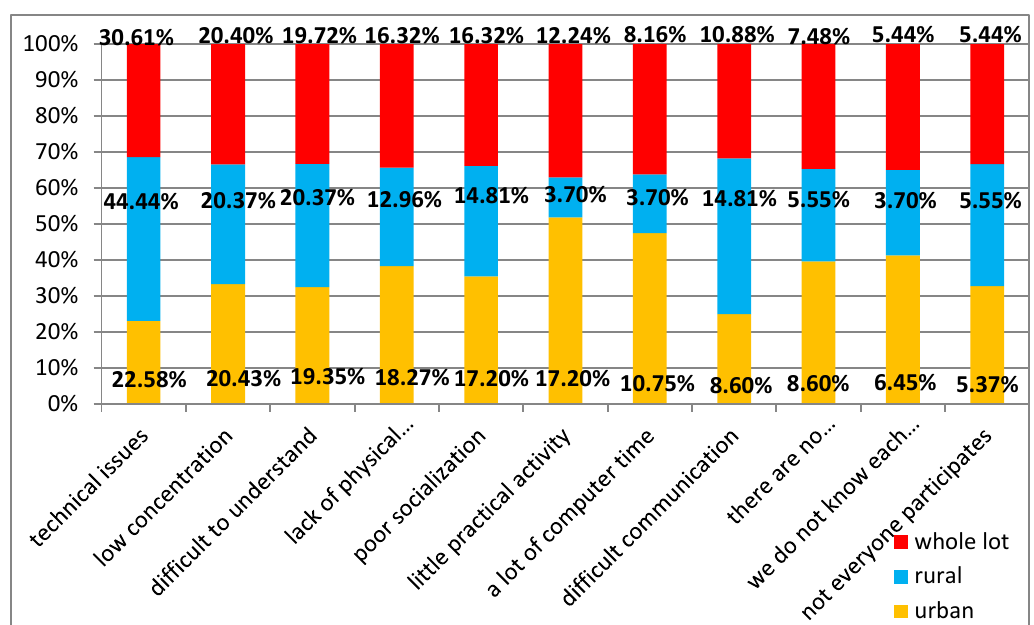
Figure 2. Graphical representation of the main disadvantages encountered in online activities.